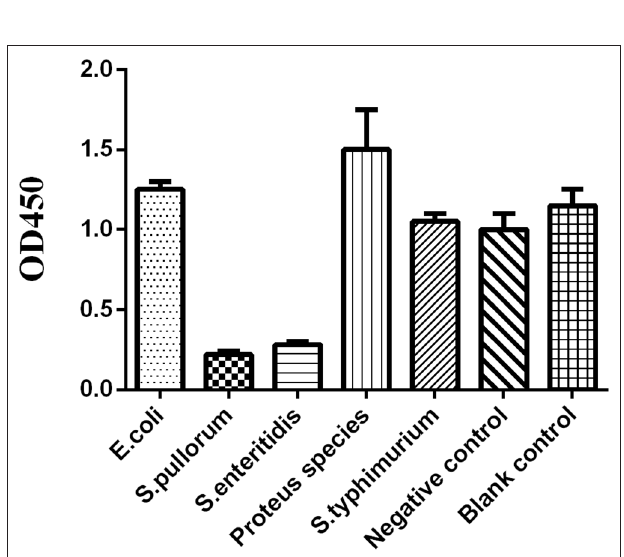
FIGURE 11 | ROC analysis curve for competitive ELISA detecting chicken serum